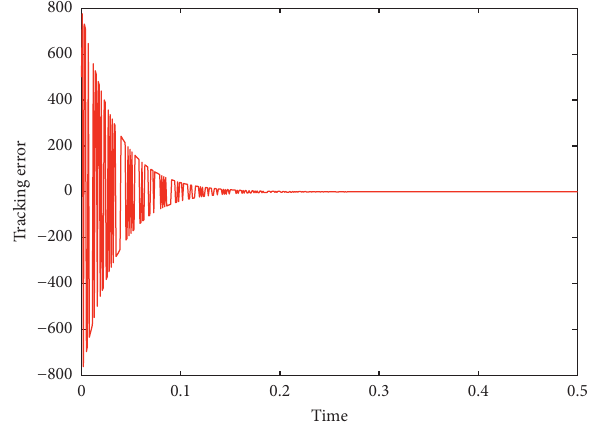
Figure 10: The curve of tracking error.